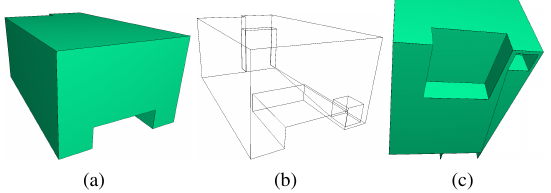
Figure 7: (a) Actual free space 3 -cell of a room with (b) wire- frame and (c) bottom-up views.